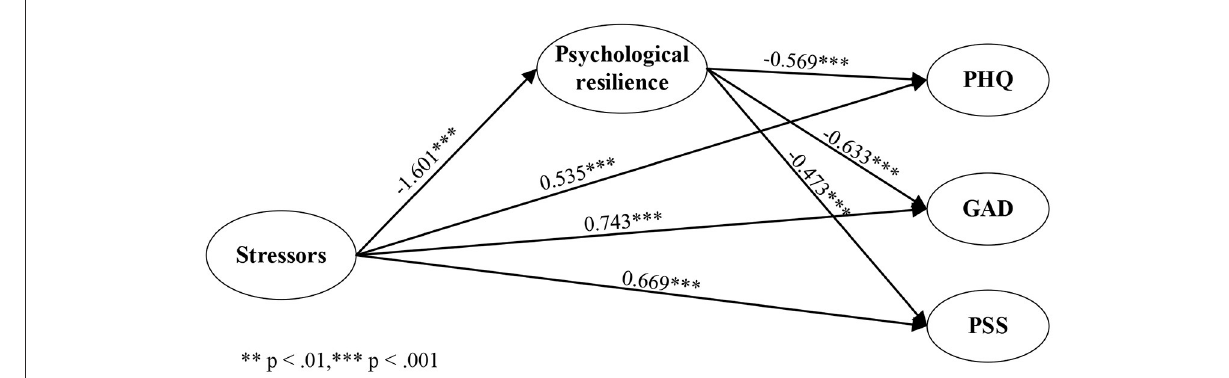
FIGURE2 Path coefficients of COVID-19 related stressors, psychological resilience, and mental health.